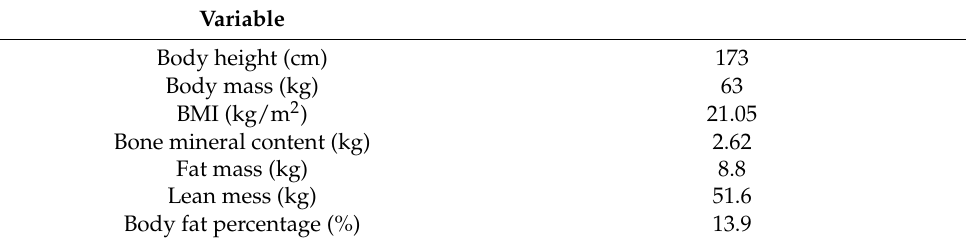
Table 5. Values of body mass and selected variables of body composition before